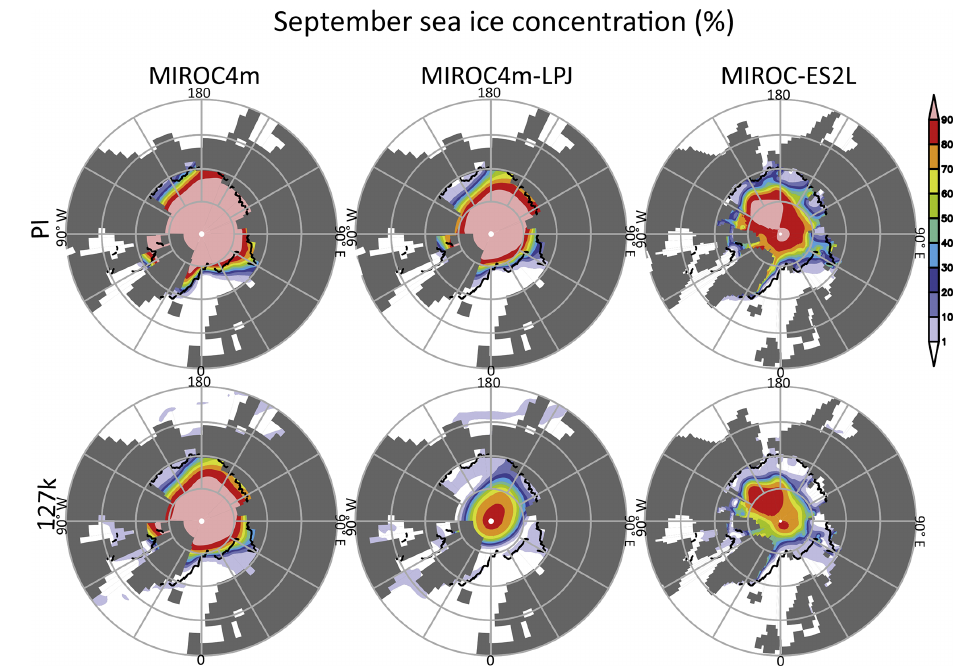
Figure 11. Same as Fig. 10 but for NH September sea ice concentration